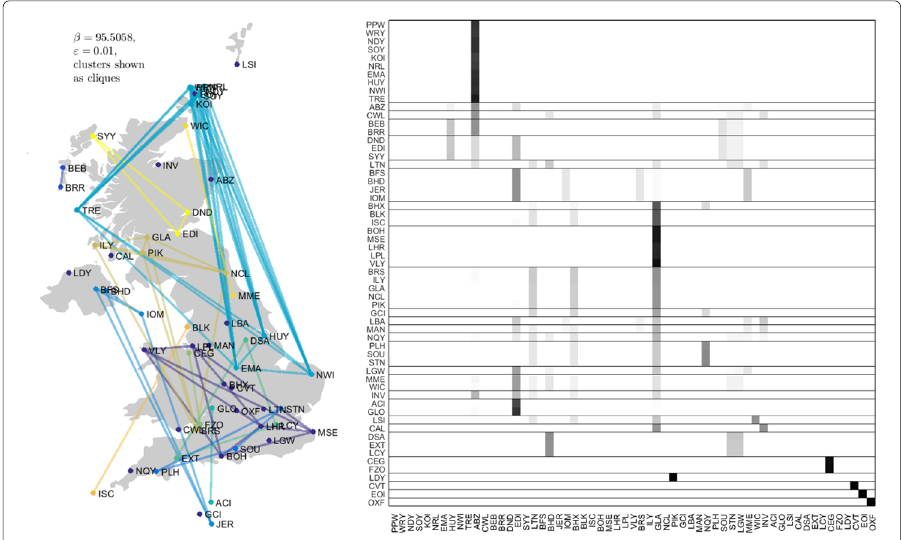
Fig. 8 Clusters from UK flight data for Thursday, 21 October 2010; otherwise as in Fig. 5. Cluster colors only distinguish clusters from each other and do not suggest affinity across